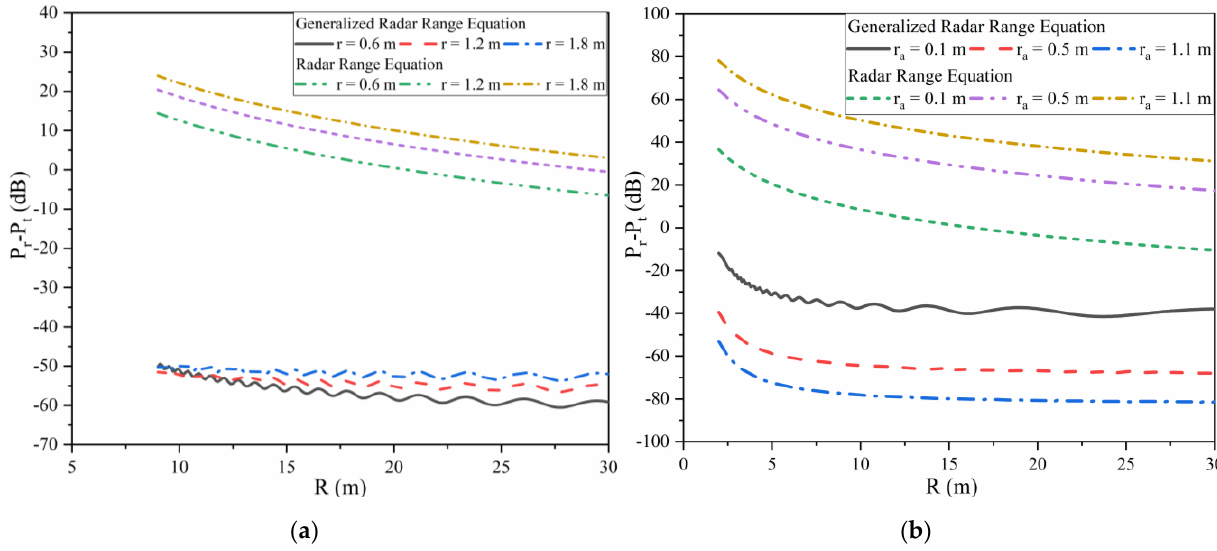
Figure 3. ( a ) THz radar detects different sizes of metal spheres. ( b ) Different THz radars detect the same metal target.